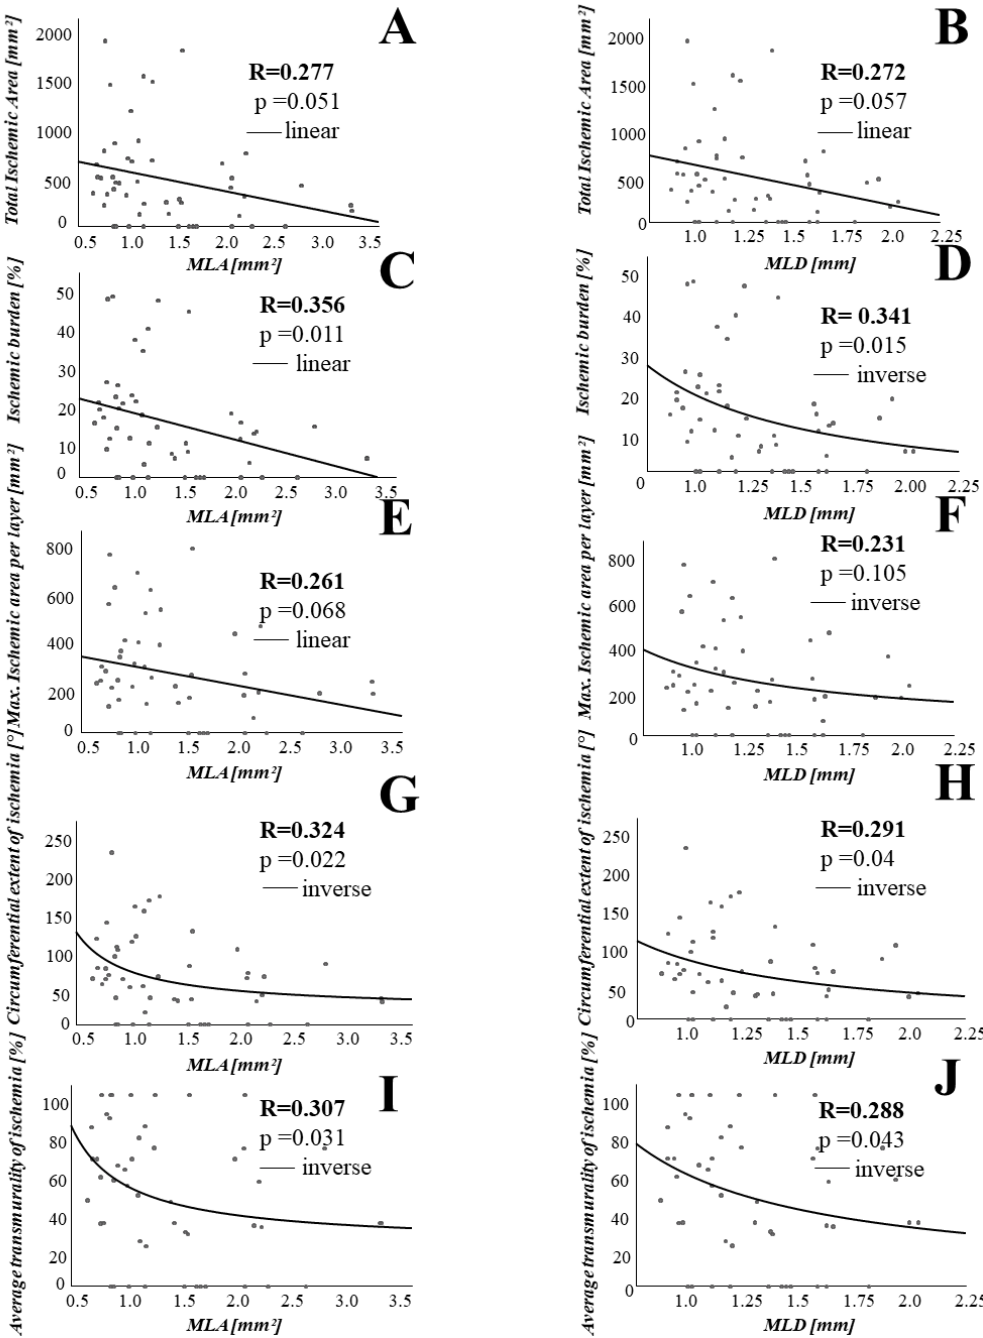
Figure 2. Minimal lumen area (MLA) and minimal lumen diameter (MLD) significantly correlate to extent of myocardial ischemia. On the X-axis, minimal lumen area (MLA) ( A , C , E , G , I ) and minimal lumen diameter (MLD) ( B , D , F , H , J ) are shown. On the Y-axis are plotted various parameters assessing the extent of myocardial ischemia.